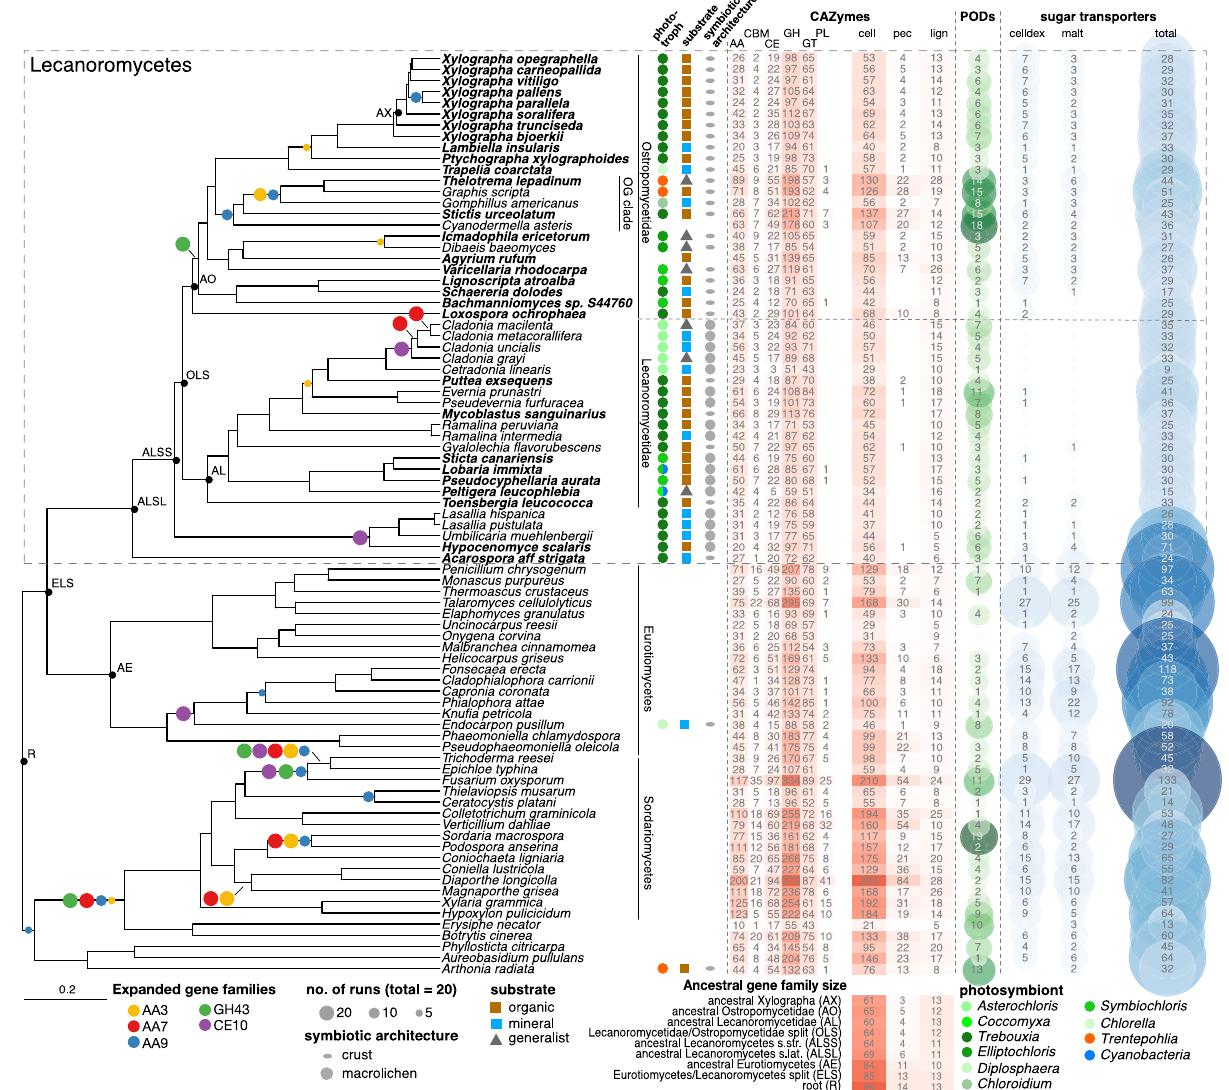
Fig. 1 Distribution and ancestral states of CAZymes and selected sugar transporters across the evolution of Lecanoromycetes and related classes of Ascomycota projected onto a maximum likelihood phylogenomic tree based on 1310 loci. Symbols beside tree tips refer to life history traits and phototrophic partners of LFS under study. Heatmaps with shades of red indicate the number of genes in different CAZyme classes or involved in degrading complex PCW components. Columns from left to right: AA Auxiliary Activities, CBM Carbohydrate binding module, CE Carbohydrate Esterases, GH Glycoside Hydrolases, GT Glycosyl Transferases, PL Polysaccharide Lyases. cell - Number of genes in 35 CAZyme families involved in cellulose and hemicellulose breakdown. pec - Number of genes in 11 CAZyme families involved in pectin breakdown. lign - Number of genes in three CAZyme families involved in lignin modi fi cation. Selection of CAZyme sets follows 9, 25 . PODs: numbers of heme haloperoxidase and DyP peroxidases potentially involved in lignin modi fi cation from Redoxibase (see text). Sugar transporters - selected PF00083 transporters. celldex - Number of cellodextrin transporters. malt - number of maltose transporters. total - Total number of other PF00083 transporters. Below the heatmap are ancestral sizes of CAZyme families involved in (hemi-)cellulose, pectin and lignin modi fi cation. Colored circles on tree branches indicate signi fi cantly expanded CAZyme families. The size of the circles indicates the number of individual CAFE runs (out of 20 total runs) in which a family was found to be signi fi cantly expanded. Expanded gene families recovered in less than fi ve runs are omitted here. Exact numbers are given in Supplementary Fig. 12. Source data are provided as a Source Data fi